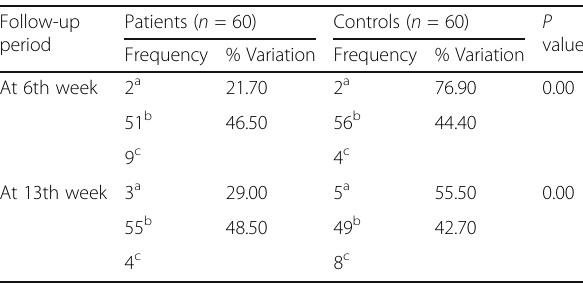
Table 6 Percentage variation in triceps skinfold thickness of participants at the 6th and 13th